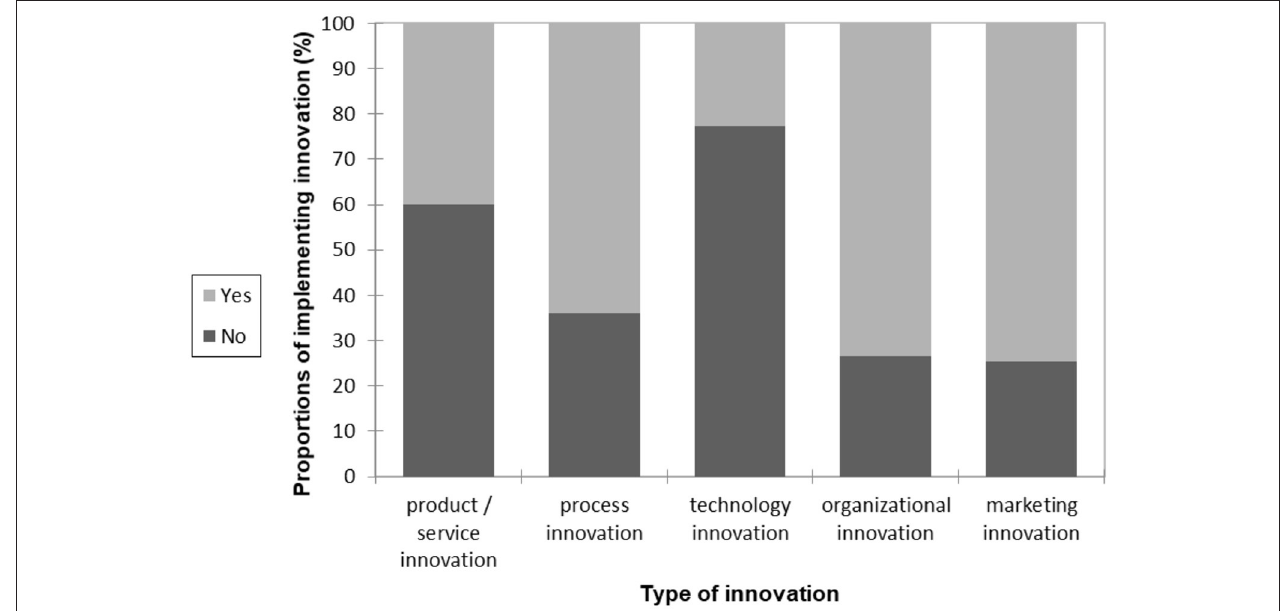
FIGURE 1 | Innovation types implemented by